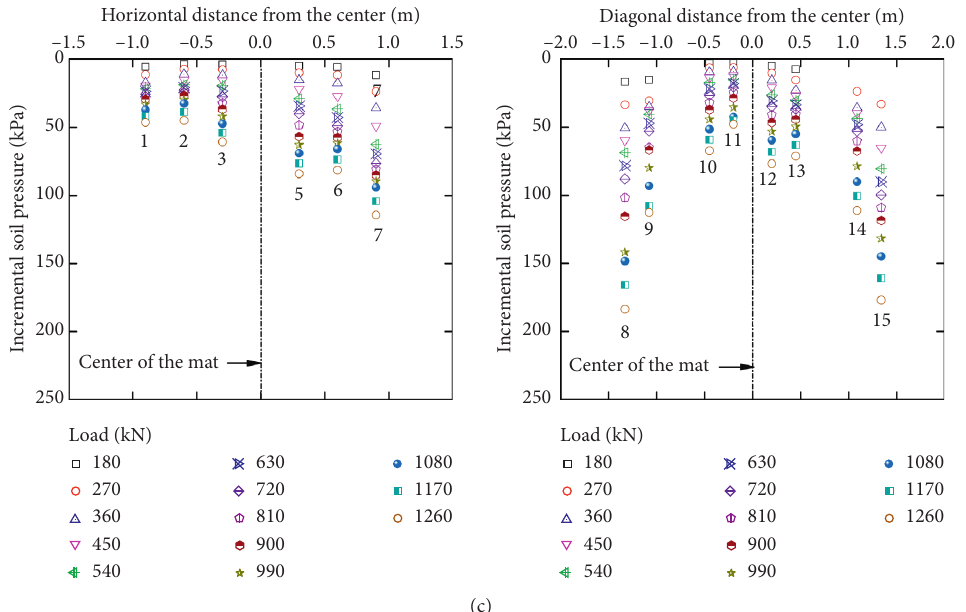
Figure 8: Distribution of incremental soil pressures underneath the footing during compression load testing for (a) CF1, (b) CF2, and (c) CF3.